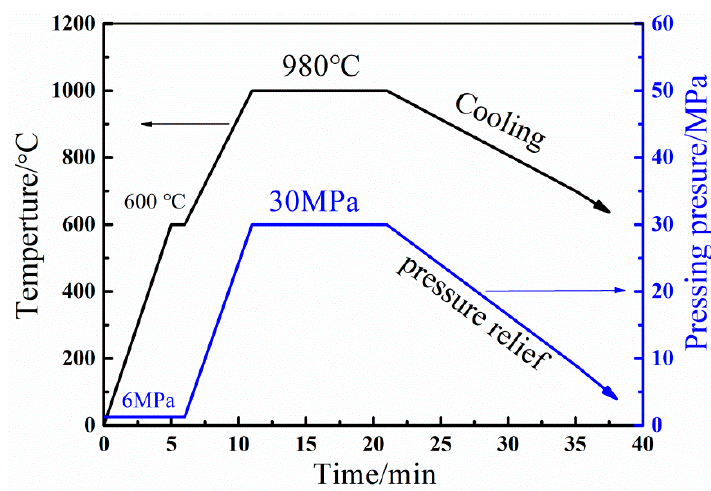
Figure 1. A B 4 C/Cu composite sintering process